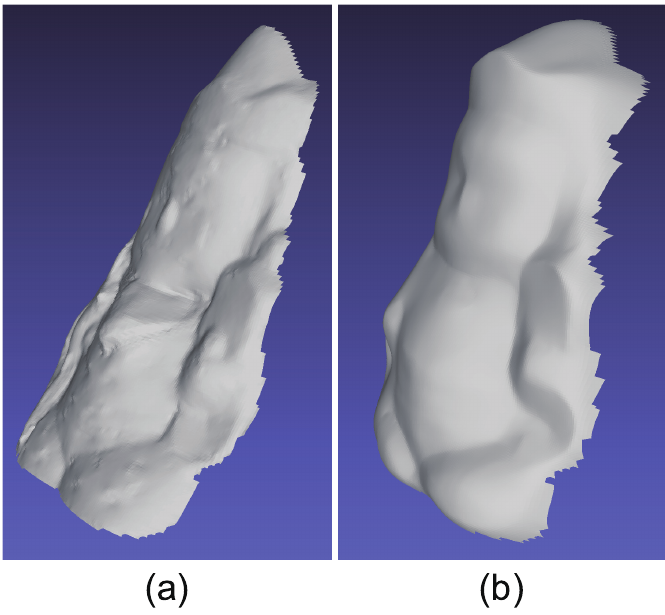
Figure 24. The results for buddha object, which causes strong specular reflection. Estimated geometry [Buddha]: ( a ) Naive color photometric stereo and ( b ) our method. The proposed method can smooth the surface normal of the scarf whose surface normal is unreliable due to black paint.